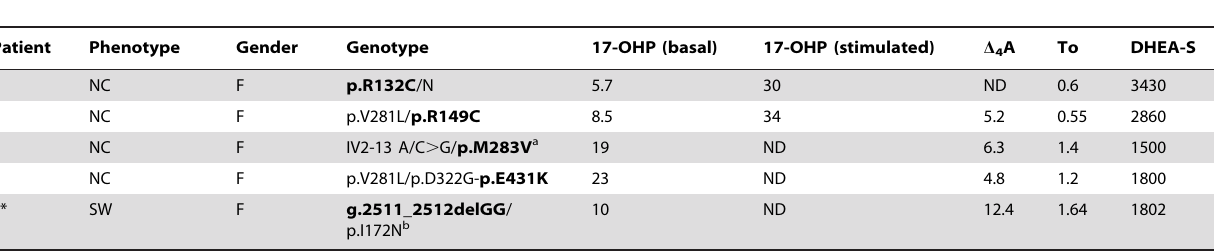
Table 1. Phenotype, genotype and hormonal values in the five patients in whom novel mutations were found.